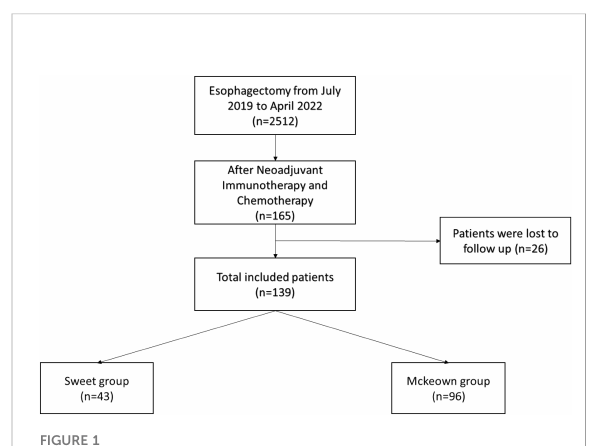
FIGURE 1 Flow diagram of the study population